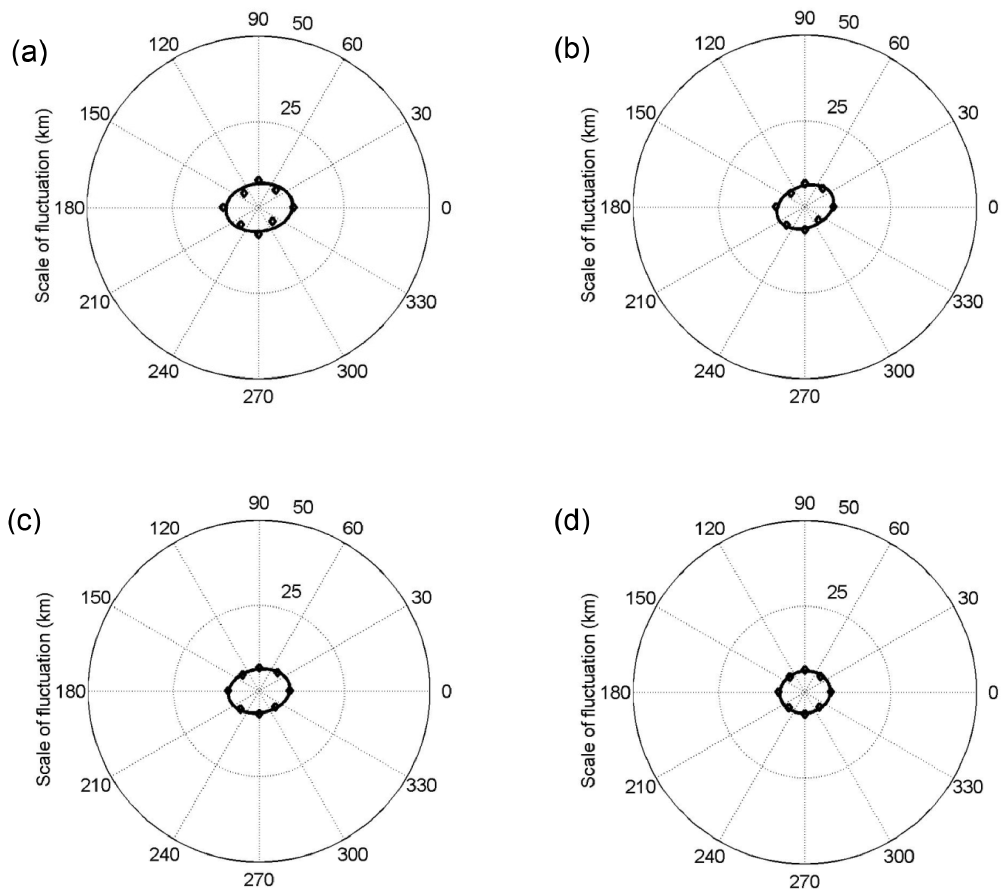
Figure 15. Scale of fluctuation values and ellipse-fitting curves for the 22–24 July 1994 storm: (a) maximum rolling 4h rainfall, (b) maximum rolling 12h rainfall, (c) maximum rolling 24h rainfall, and (d) maximum rolling 36h